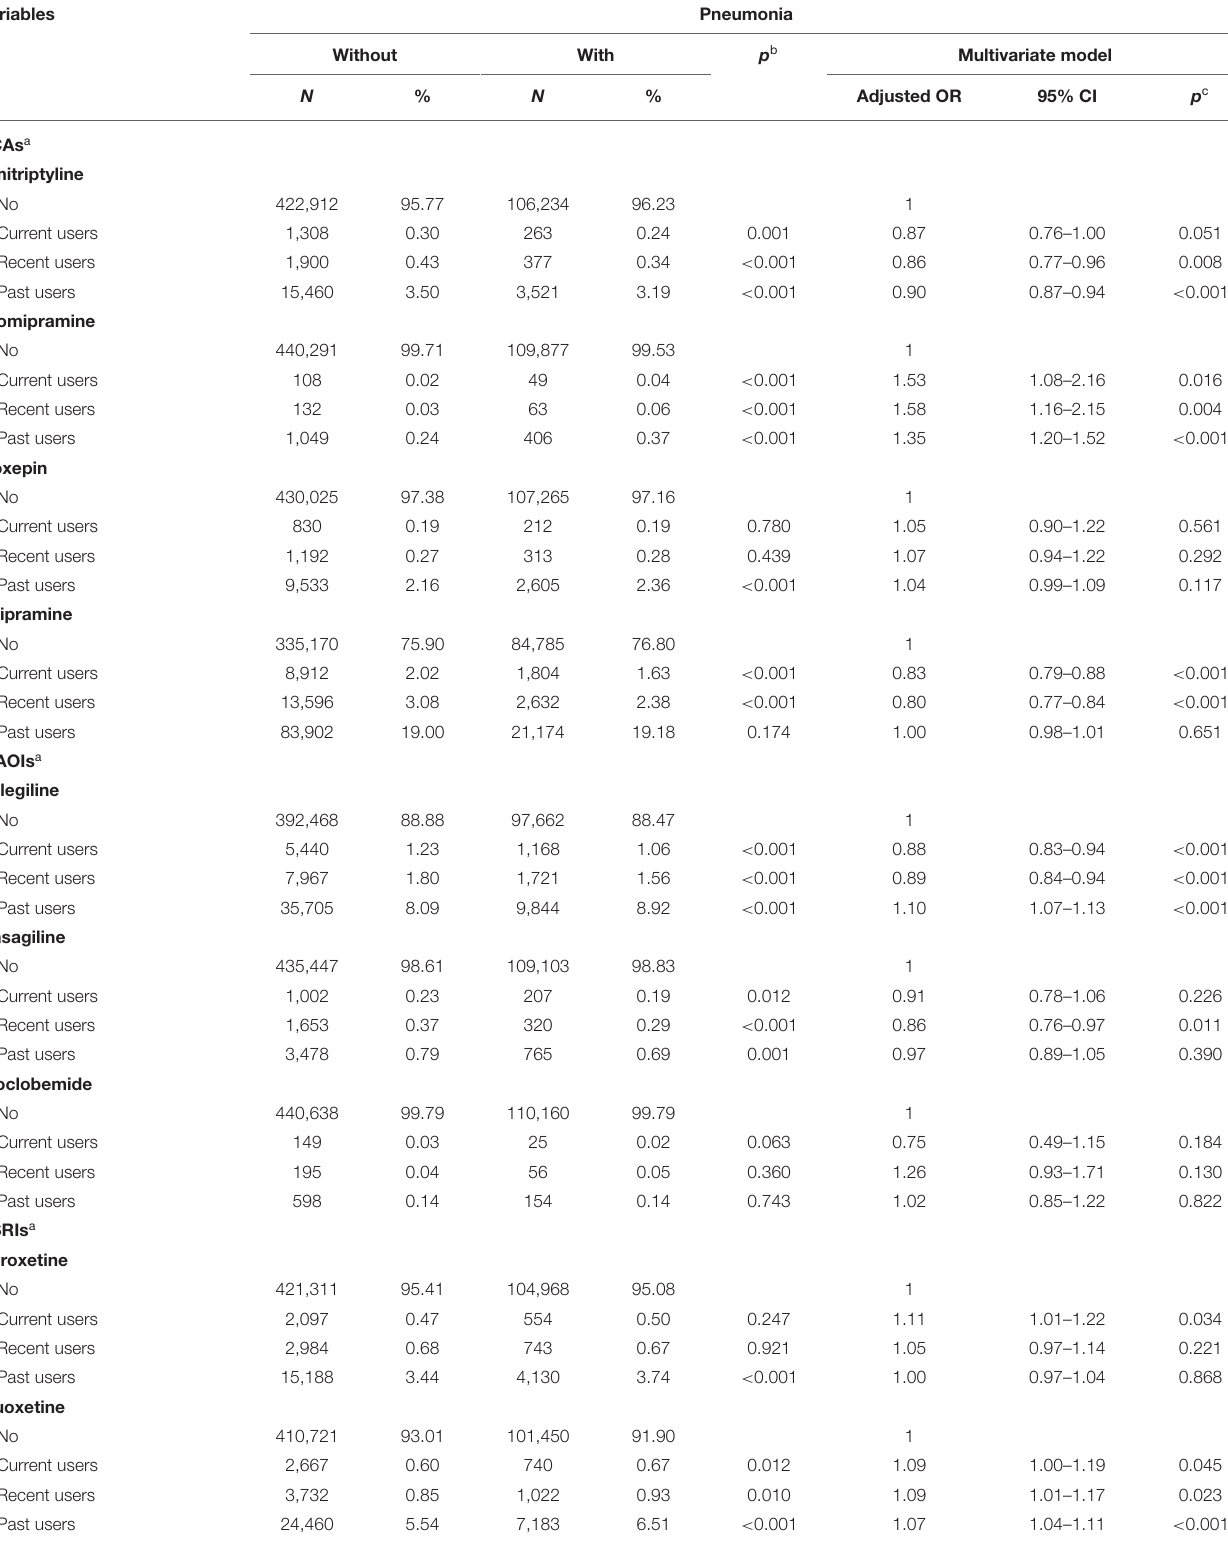
TABLE 3 | The association of incident pneumonia and individual antidepressants use. Variables